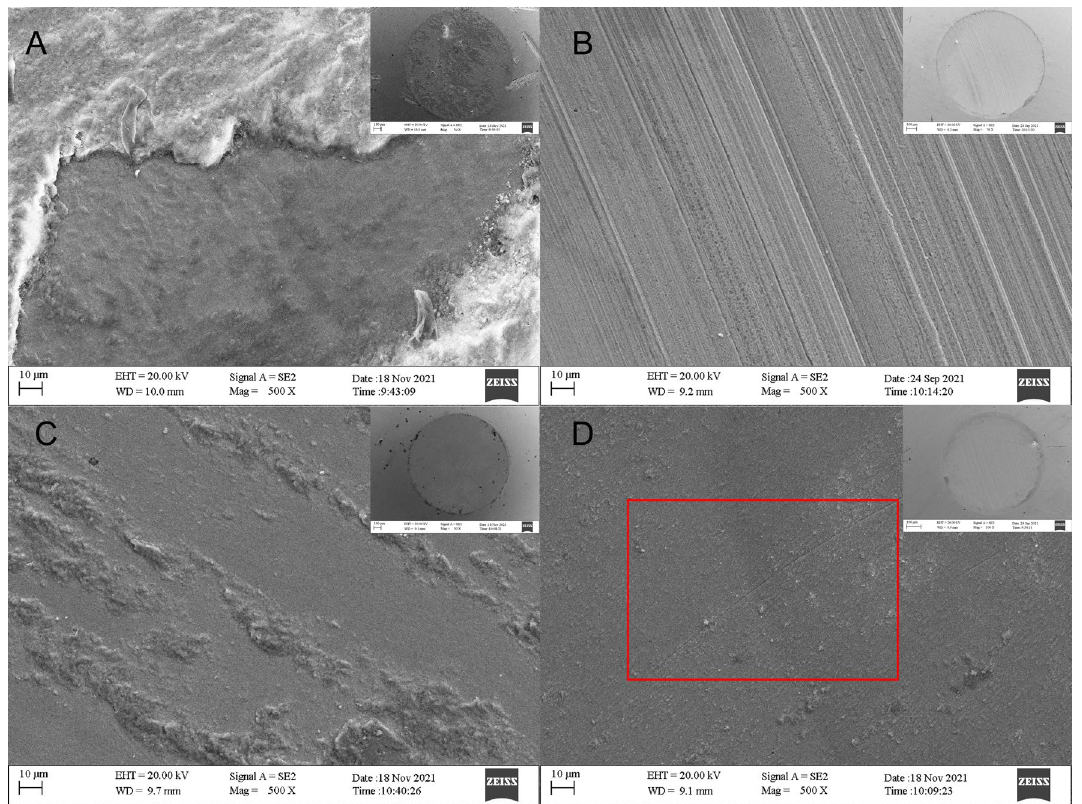
Fig.12 SEM images of worn surface of steel ball under 392 N a paraffin liquid; b PDABNNS oil; c f-CuO oil; d CuO@BNNS